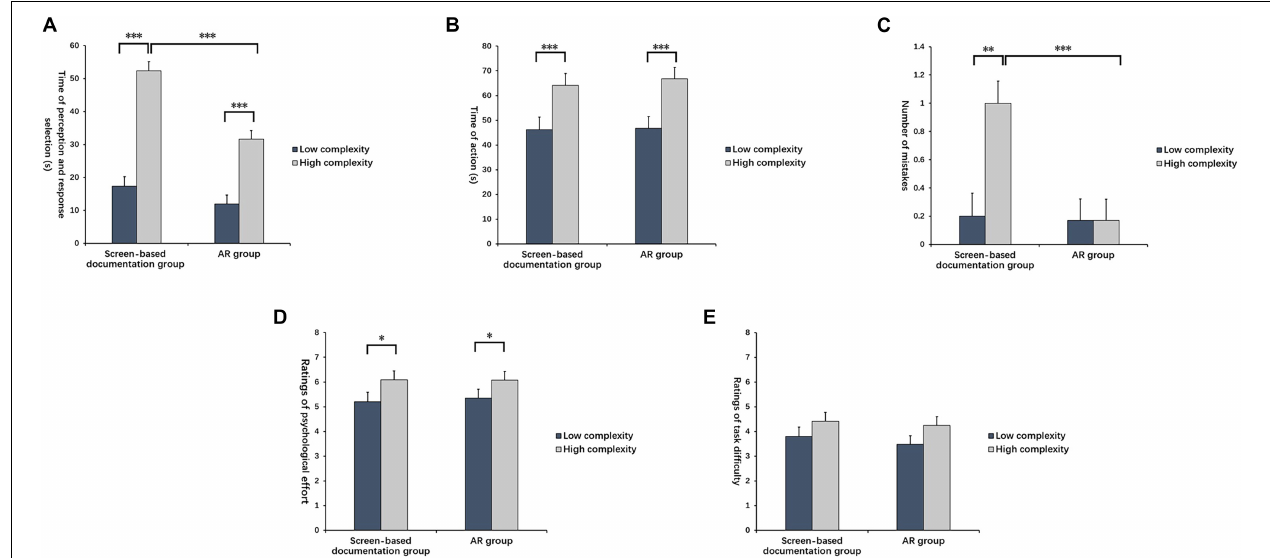
FIGURE 11 | Indexes in joining subtask with various complexities under two assistance modes. (A) Time of perception and response selection, (B) Time of action, (C) Number of mistakes, (D) Ratings of psychological effort, and (E) Ratings of task difficulty. ∗ Indicates p < 0.05; ∗∗ indicates p < 0.01; ∗∗∗ indicates p < 0.001.